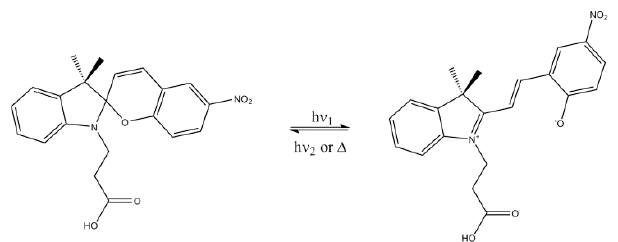
Figure 1. Structural transformation of an acid spiropyran derivate (SPCOOH) from SP isomer ( left ) and merocyanine (MC) isomer ( right ).